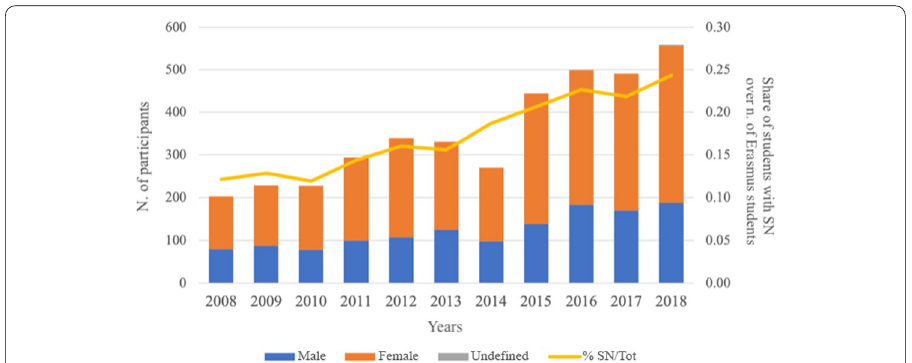
Fig. 1 Evolution of the participation of students with special needs to Erasmus. The bars indicate the number of participants for each year (to be read on the left vertical axis). The yellow line represents the share (%) of students with special needs over the total number of Erasmus students (to be read on the right vertical